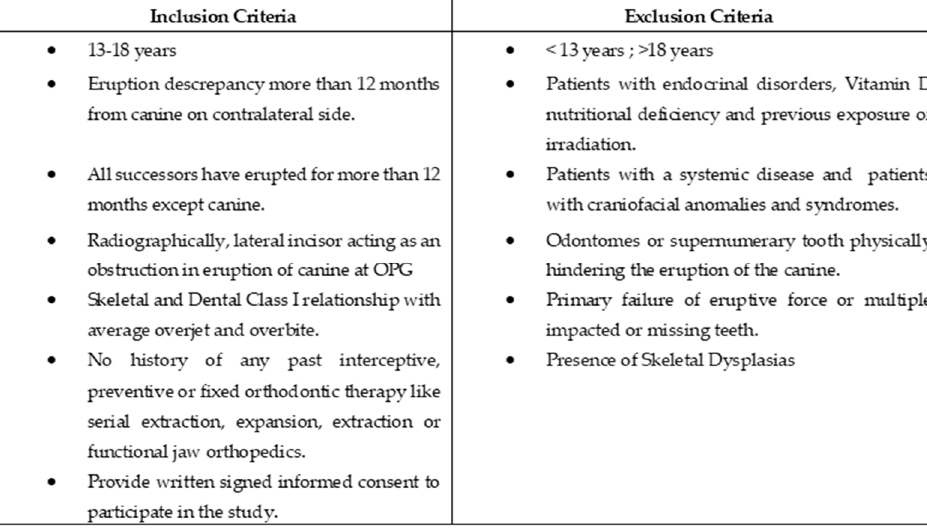
Figure 1. Inclusion and Exclusion criteria.